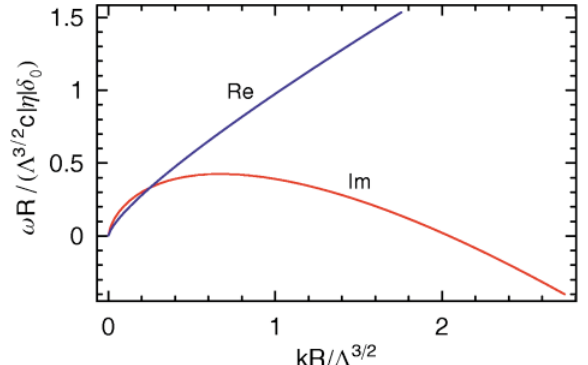
FIG. 1. (Color) The imaginary (Im) and real (Re) parts of the frequency v as functions of kR (cid:3) L 3 (cid:3) 2 , for a positive value of h . For negative values of k , the frequency can be found from the relation v (cid:1) 2 k (cid:2) (cid:1) 2v (cid:1) (cid:1) k (cid:2) which follows from Eq. (9). the screening effect of the vacuum chamber walls, and the beam emittance (see